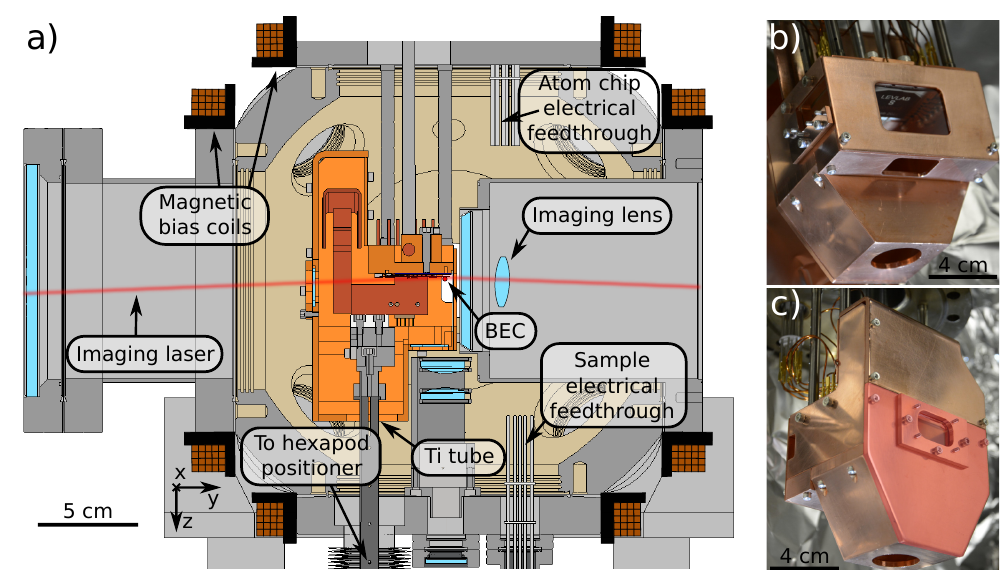
Figure 3: The radiation shield. (a) Cross section of the science chamber as viewed along the optical dipole trap axis. The BEC (red) is imaged using a 780 nm laser beam (transparent red) reflected off the sample at a shallow angle. (b, c) The assembled atom chip mount and radiation shield as viewed outside the apparatus from the (b) front and (c) back. The atom chip is visible through the front imaging window in (b). A portion of the shield, shaded red in (c), can be easily removed to load a new sample. The sample mount and the cryostat are not present in these